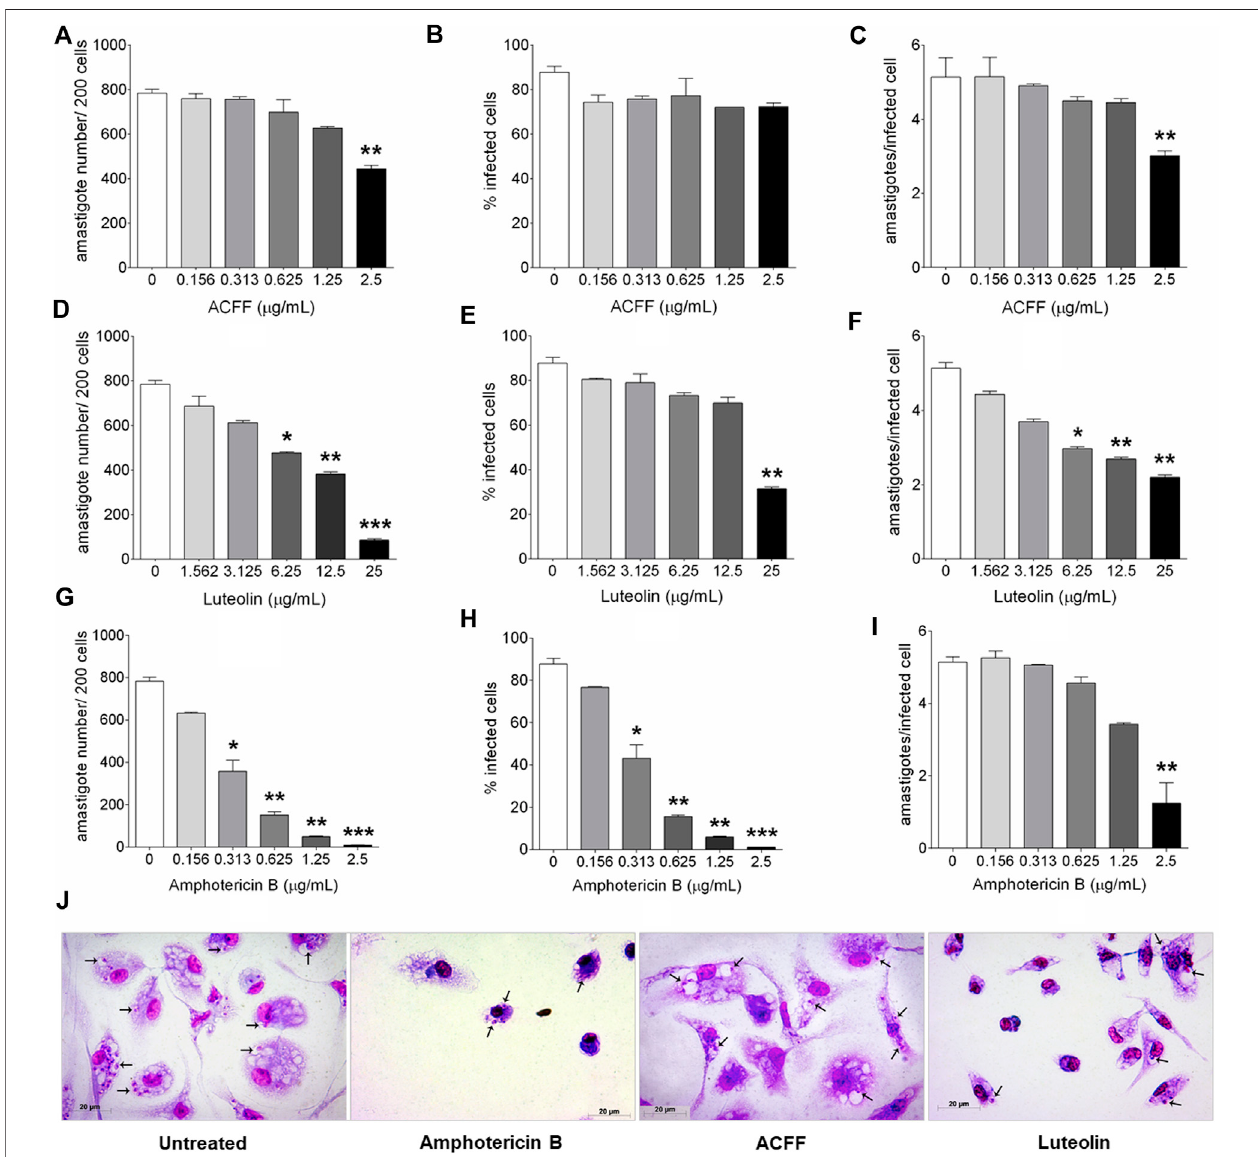
FIGURE 3 | BALB/c peritoneal macrophages infected with Leishmania amazonensis and treated for 24 h with amphotericin B, Arrabidaea chica fl avone-rich fraction (ACFF) or luteolin. (A – I) Parameters ofinfection and (J) light microscopy ofuntreated, and treated with amphotericin B(2.5 μ g/mL), ACFF (2.5 μ g/mL) or luteolin (25 μ g/mL) infected cells. (black arrows) Intracellular amastigotes inside macrophages. The images and data (mean ± standard deviation) represent two independent experiments performed in triplicate. * p < 0.05, ** p < 0.01 and *** p < 0.001 when compared with untreated infected cells by Kruskal – Wallis and Dunn ’ s multiple comparison test. Giemsa, 40 ×